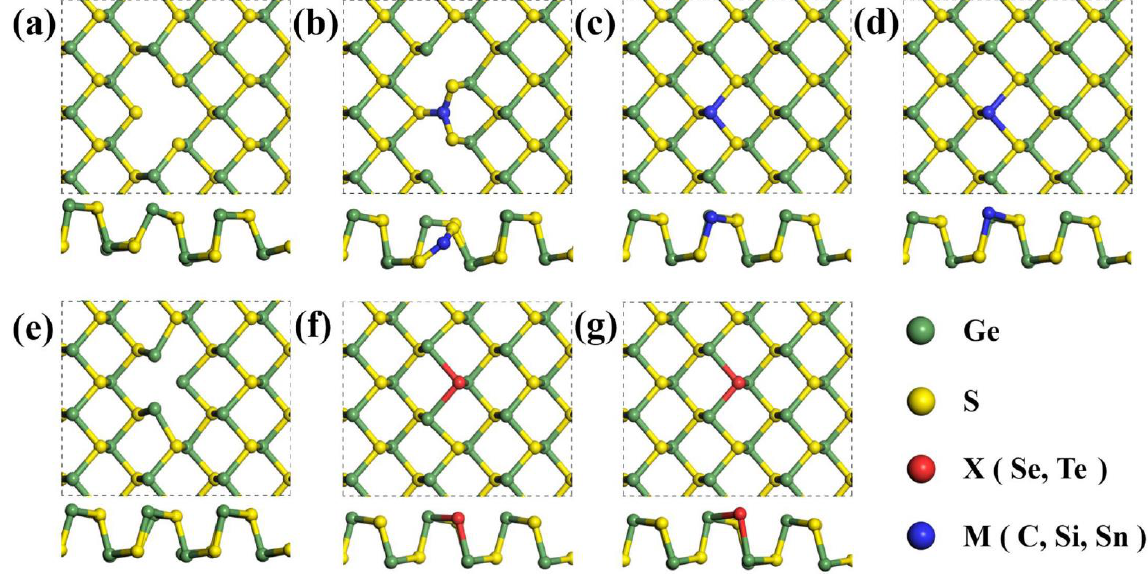
Figure 2. Structures of ( a ) Ge vacancy ( 𝐕 𝐆𝐞 ) and ( b ) substitutional C ( 𝐂 𝐆𝐞 ), ( c ) substitutional Si ( 𝐒𝐢 𝐆𝐞 ), and ( d ) substitutional Sn ( 𝐒𝐧 𝐆𝐞 ) for Ge vacancy; structures of ( e ) S vacancy ( 𝐕 𝐒 ) and ( f ) substitutional Se ( 𝐒𝐞 𝐒 ) and ( g ) substitutional Te ( 𝐓𝐞 𝐒 ) for S vacancy. For perspective views of atomic structures of pristine and defective GeS are shown in Figure S1.